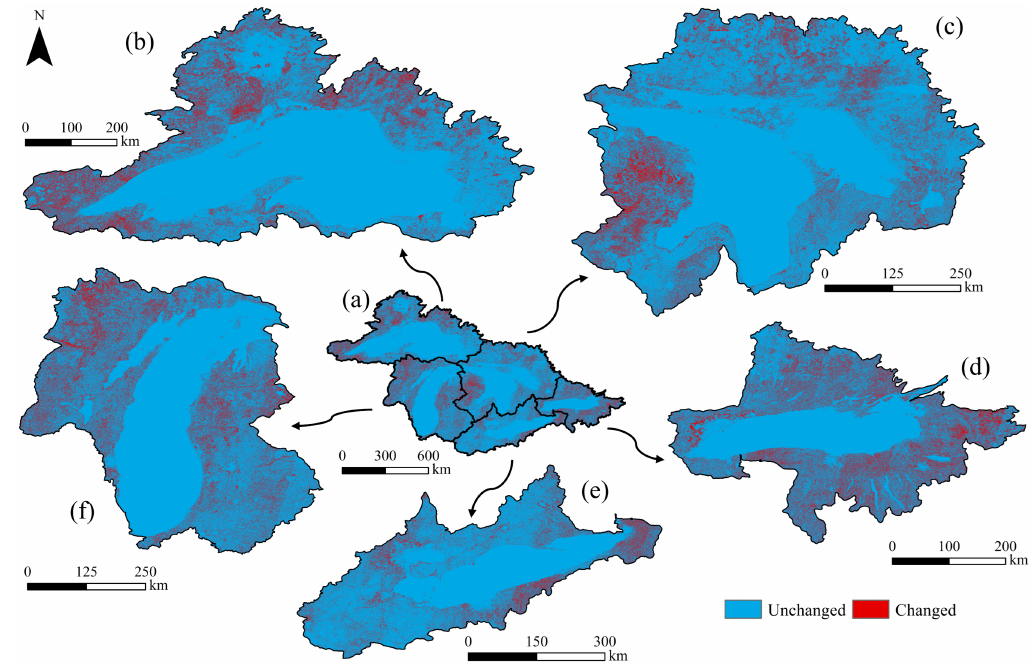
Figure 11. The produced changed and unchanged binary map of the ( a ) Great Lakes and ( b – f ) its subbasins (i.e., Lake Superior, Lake Huron, Lake Ontario, Lake Erie, and Lake Michigan, respectively) between 1984 and